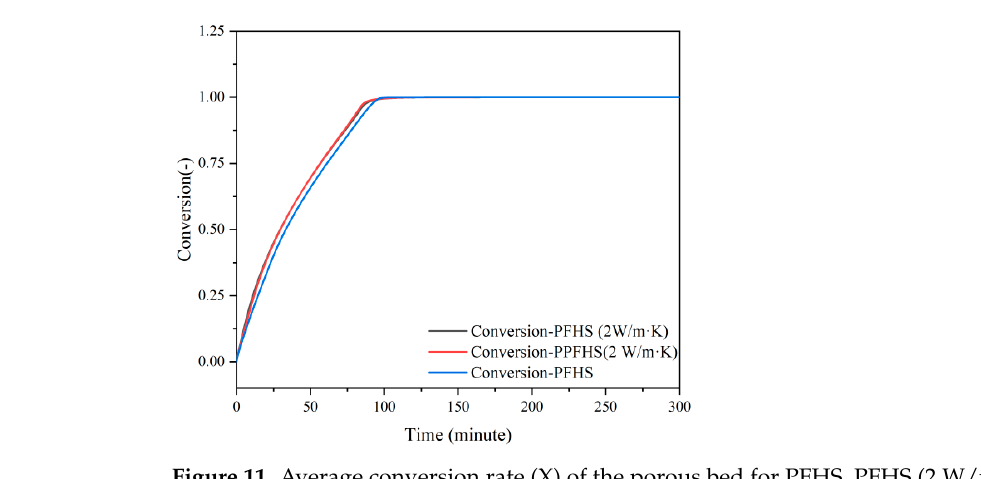
Figure 11. Average conversion rate (X) of the porous bed for PFHS, PFHS (2 W/m · K) and PPFHS (2 W/m · K) reactors (hydration, ε = 0.5, u = 25 m/s).